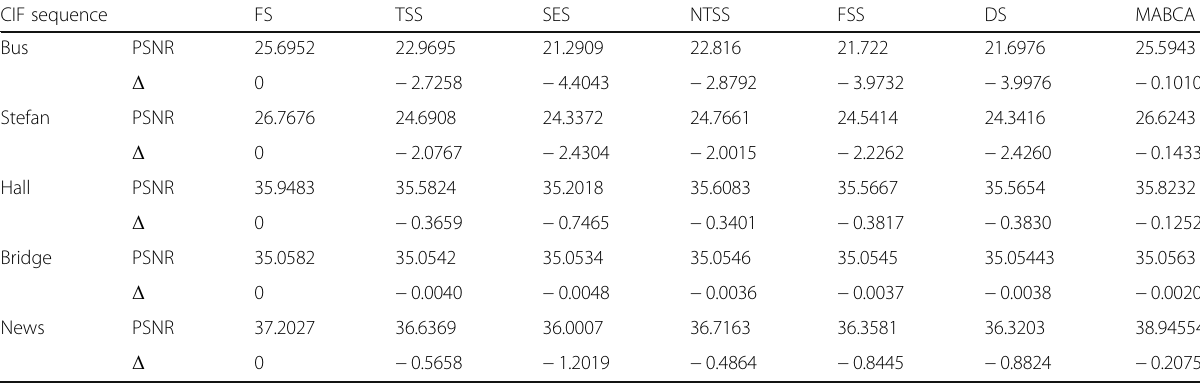
Table 4 The average PSNR values of the five CIF sequences using the seven methods CIF